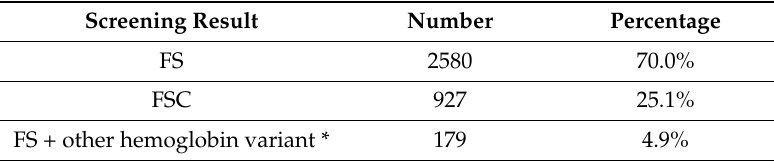
Table 1. Screen positive babies between 2005 and 31 March